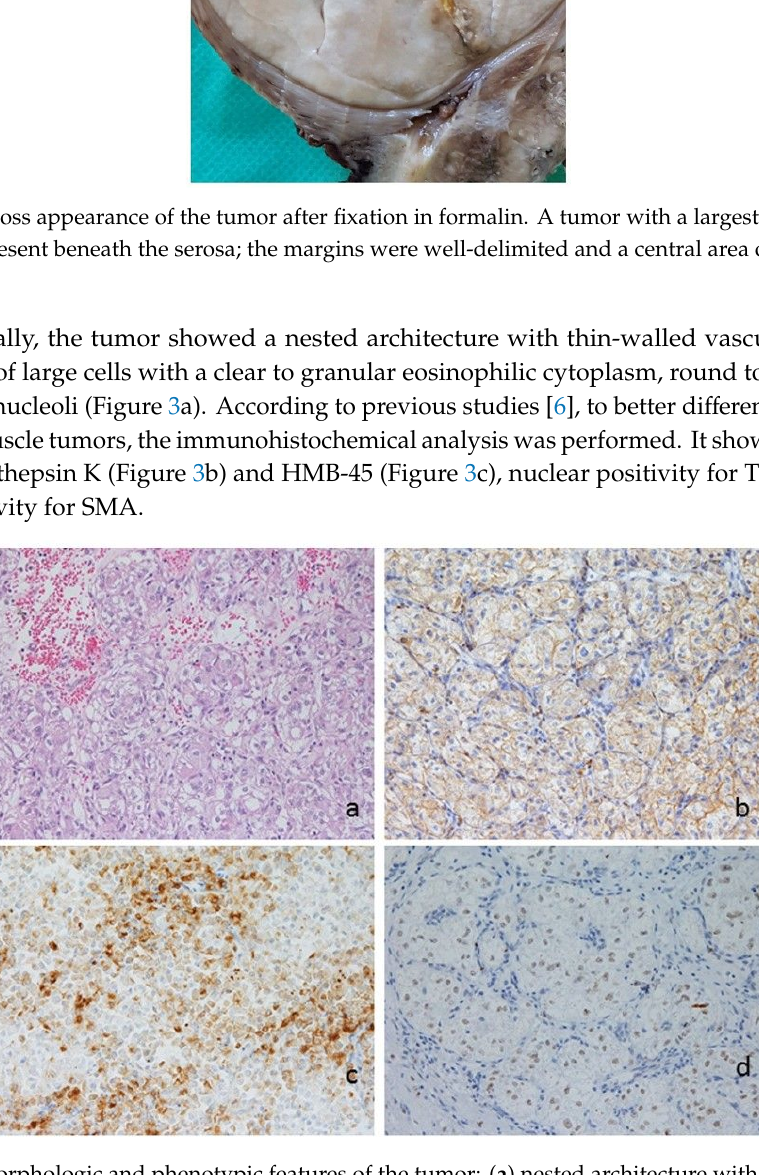
Figure 3. Morphologic and phenotypic features of the tumor: ( a ) nested architecture with thin-walled vascular spaces and a composition of large cells with a clear to granular eosinophilic cytoplasm, round to ovoid nuclei and prominent nucleoli (hematoxylin and eosin, 400×); ( b – d ) immunohistochemical stainings returned positive for cathepsin K ( b ), HMB-45 ( c ), and TFE3 ( d , 400×).